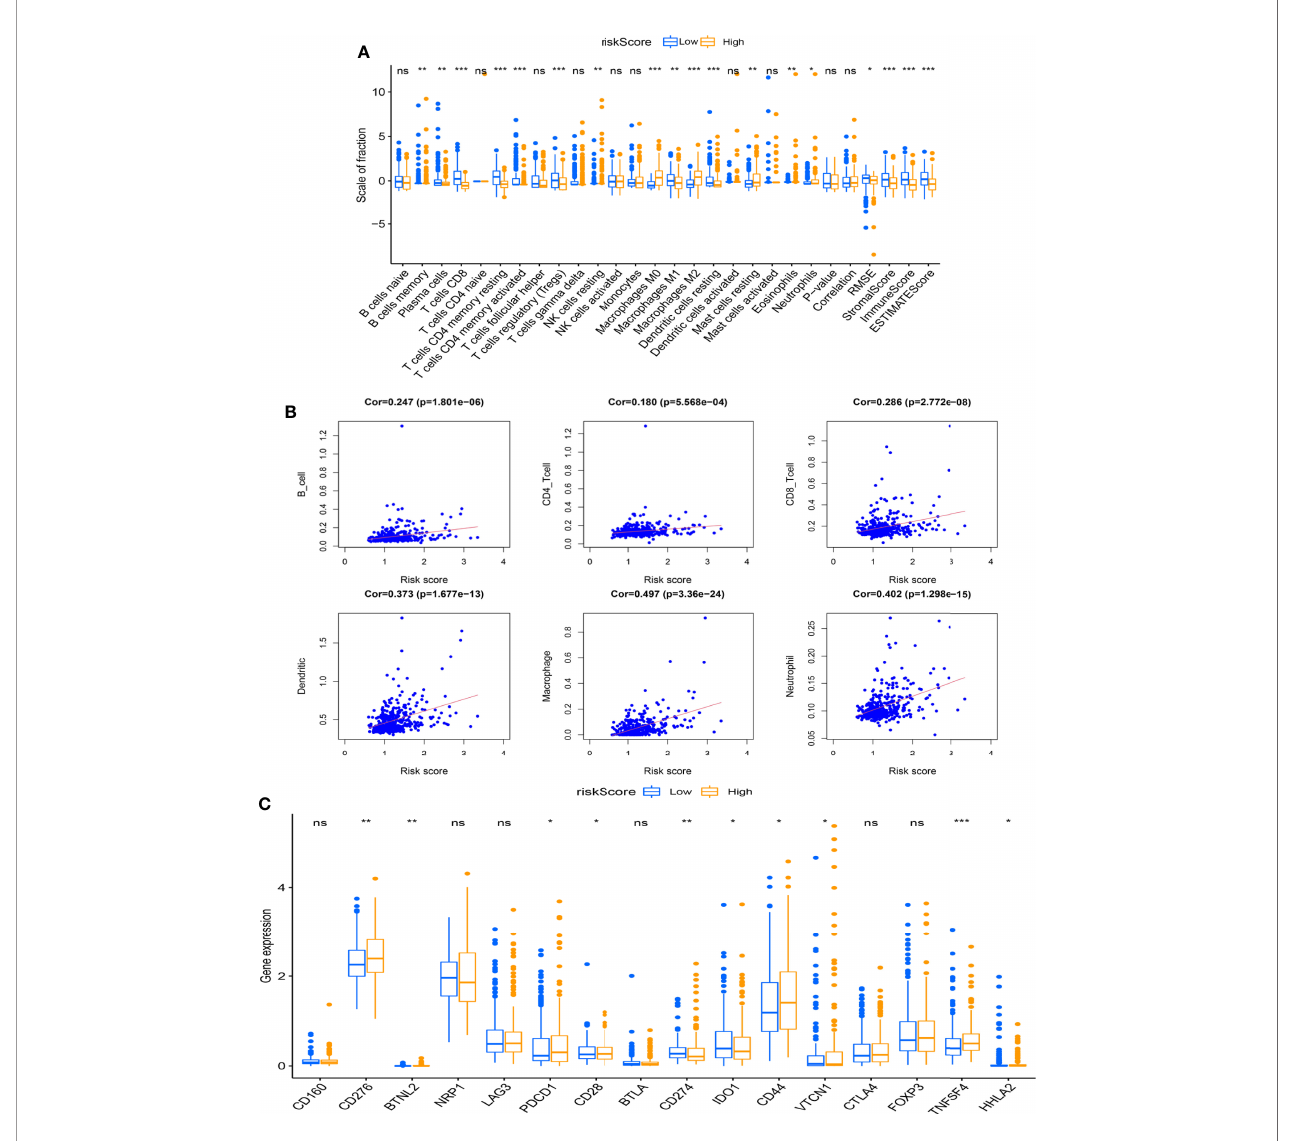
FIGURE 7 | Association between the risk score and immune in fi ltration. (A) The boxplot displays the differences in tumor-in fi ltrating immune cell (TIC) expressions and ESTIMATE score between different risk scoring groups (*p < 0.05, **p < 0.01, ***p < 0.001). (B) The scatter chart shows the correlation between the risk score and TICs. (C) The boxplot indicates the differences of immune checkpoint expressions between different risk scoring groups (*p < 0.05, **p < 0.01, ***p < 0.001). ns, no signi fi